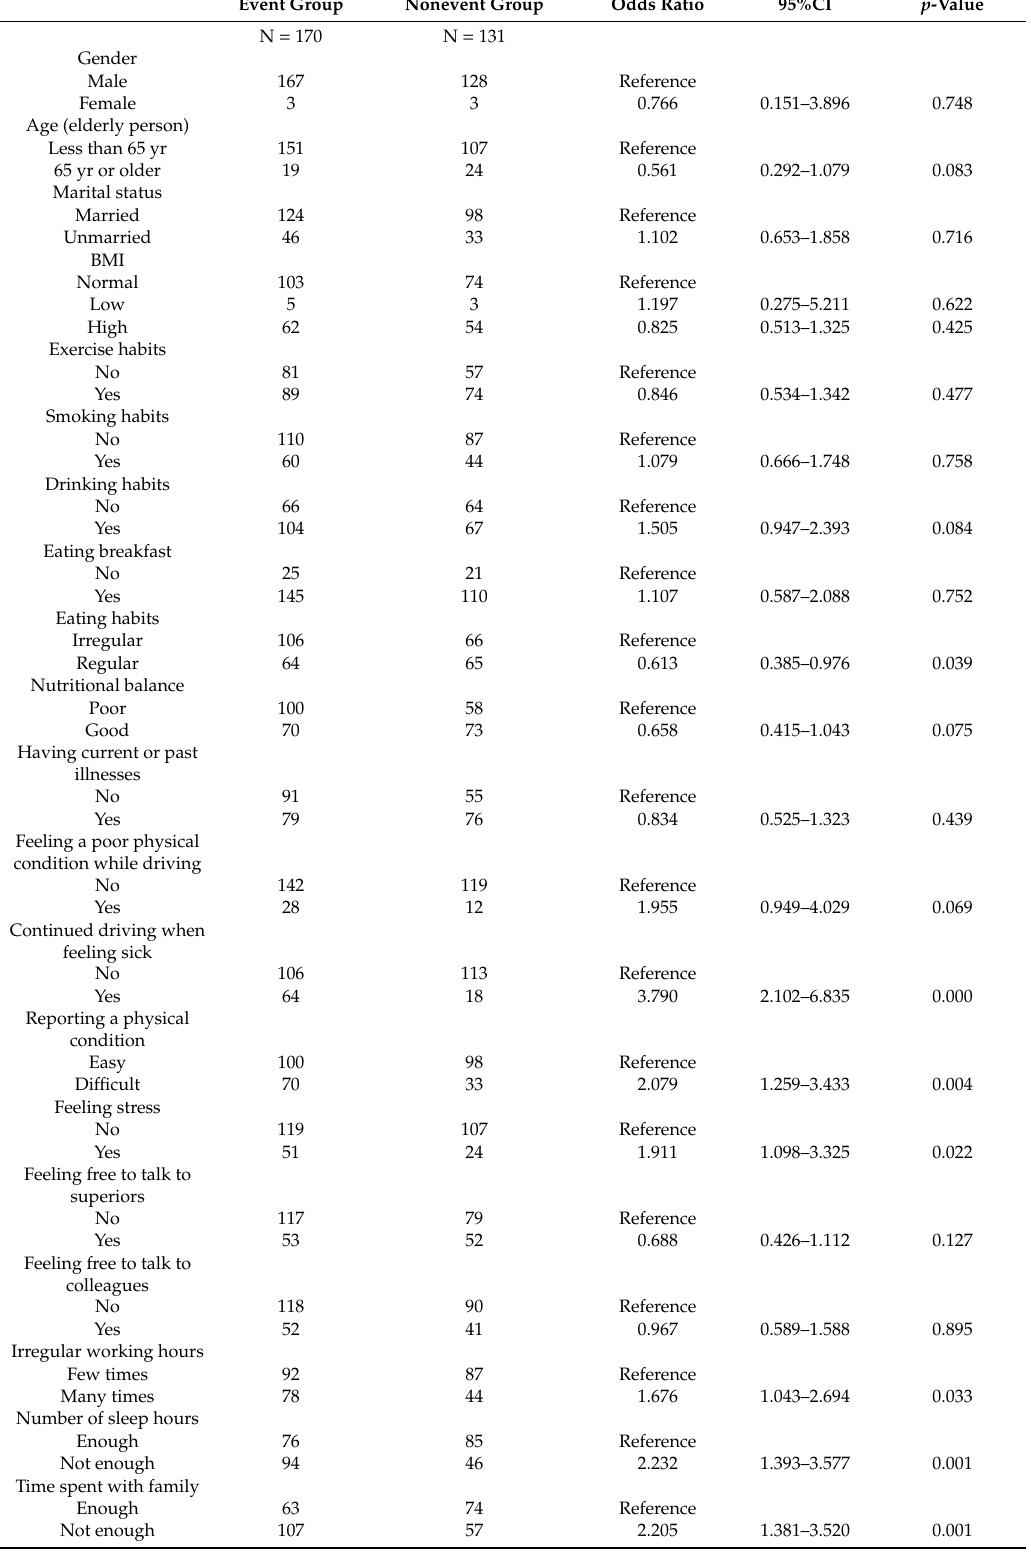
Table 2. Univariable logistic regression analysis of risk factors for collisions and near